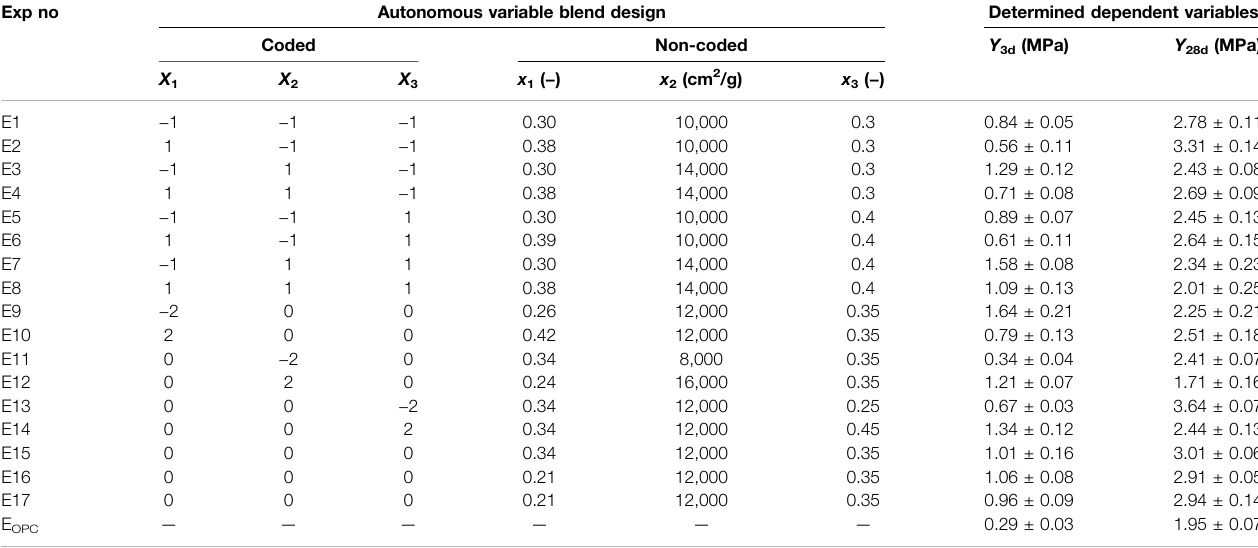
TABLE 3 | CCD and determined reliant variables.